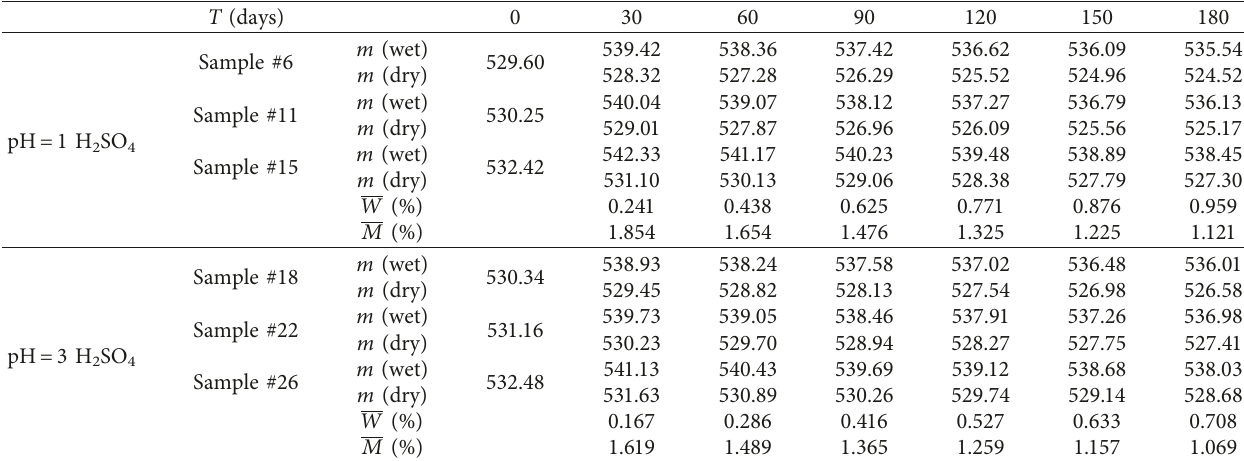
Figure 5: Variation curves of the pH values of sulfuric acid solution with time: (a) pH Table 3: Mass change of the sandstone samples soaked in acid